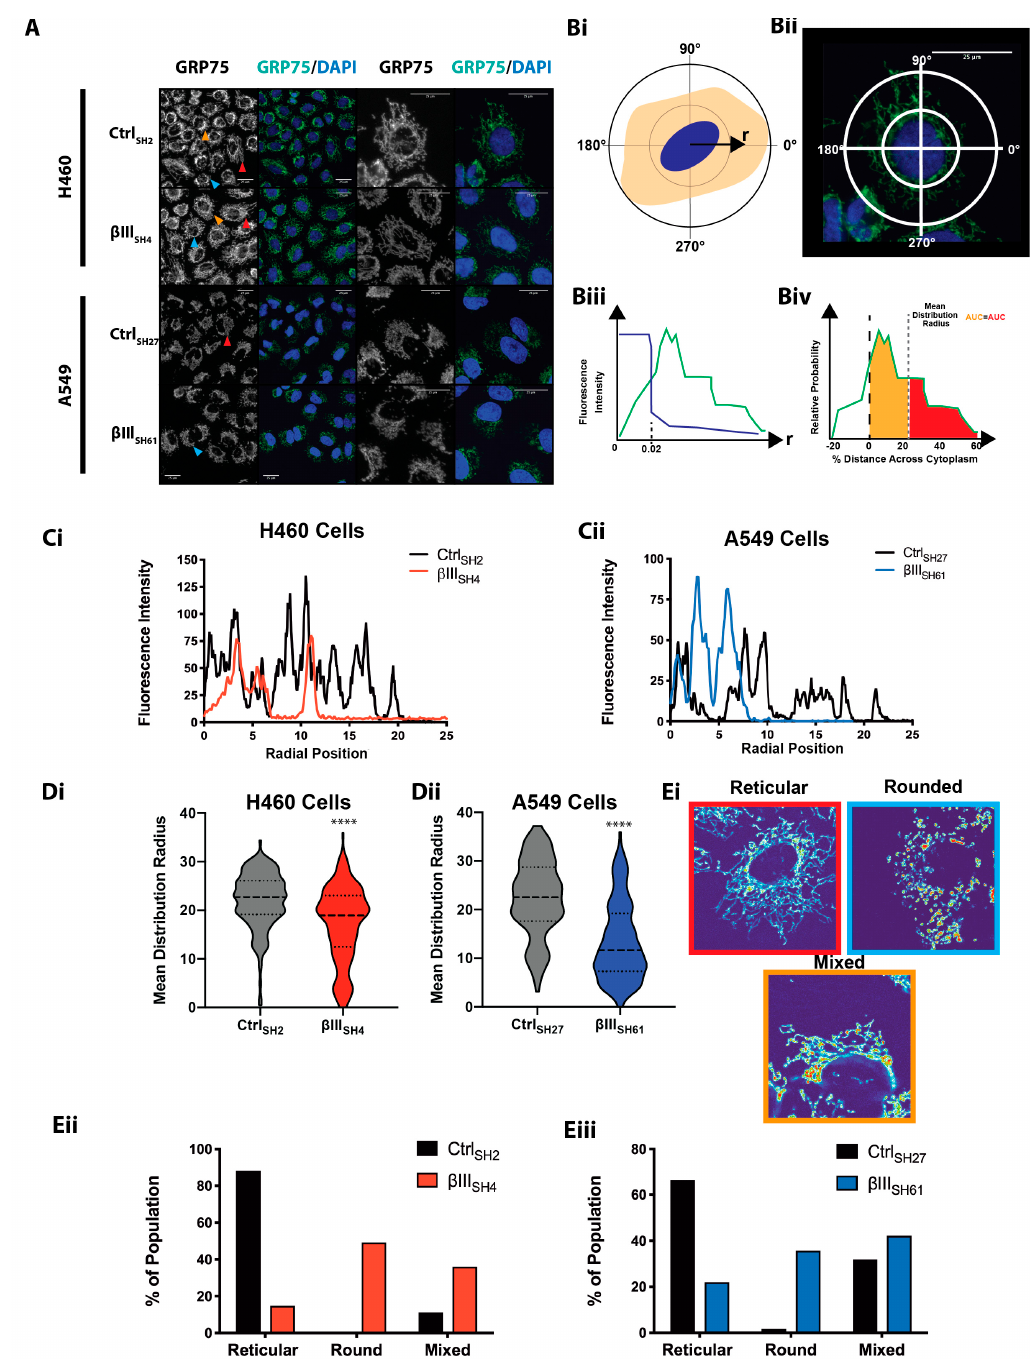
Figure 1. β III-tubulin regulates mitochondrial network structure and morphology. ( A ) Mitochondrial network distribution by GRP75 immunofluorescence staining (left panel: greyscale; right panel: GRP75 green, DAPI blue) in NCI-H460 and A549 cells expressing control (NCI-H460 Ctrl SH2 , A549 Ctrl SH27 ) and β III-tubulin targeted shRNA (NCI-H460 β III SH4 , A549 β III SH61 ). Red arrowhead: reticular mitochondrial morphology; blue arrowhead: rounded morphology; orange arrowhead: mixed morphology. Scale bars 25um. Representative of n = 3 independent experiments. Pseudocolored images show signal intensity from low (blue) to high (red) with high magnification images in Supplementary Figure S1A. ( B ) Workflow overview to measure the distribution of mitochondrial throughout the cytoplasm. Signal intensities for individual cells are transformed into polar co-ordinates defined as a radial distance from the centre of the nucleus at a specific angle ( Bi , Bii ). The edge of the nucleus and cytoplasm is defined ( Biii ) and the signal intensity is scaled to 0 to 100% corresponding to the centre of the nucleus (0%) to the edge of the cytoplasm (100%), with the edge